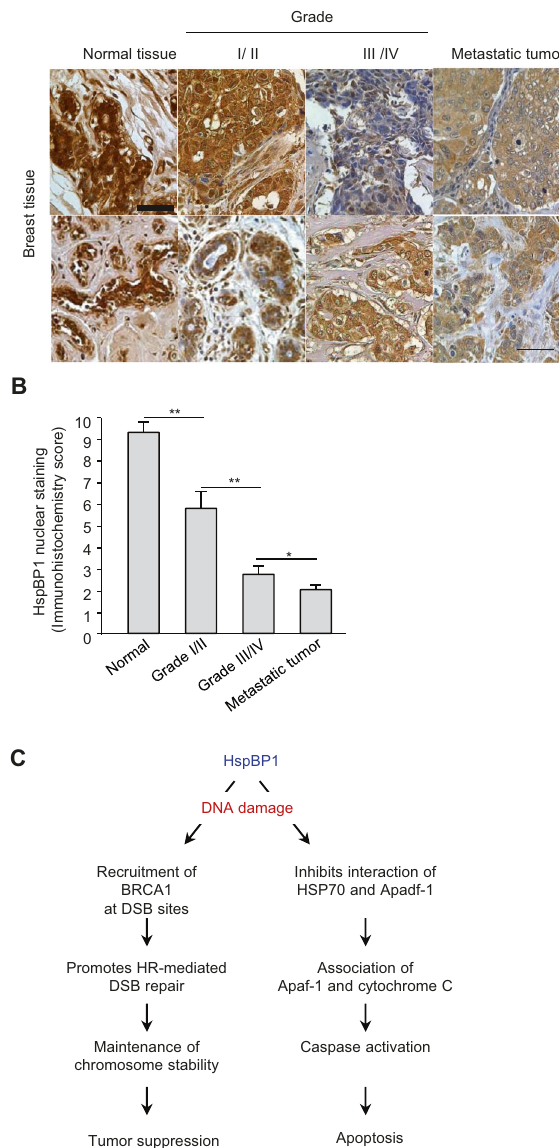
Fig. 8 Expression of HspBP1 in normal and neoplastic breast tissues. A HapBP1 proteins in normal breast tissue, grade I/II, grade III/IV, and metastatic breast carcinoma are visualized using immu- nohistochemistry with an anti-HapBP1 antibody. The brown color indicates positive HspBP1 staining. Nuclei are stained with DAPI (blue). B Nuclear immunoreactivity for HspBP1 was blind-assessed and quanti fi ed by scoring for staining intensity and percent positive cells (see Materials and Methods) in tumor section of grade I/II, III/IV, metastasis, and normal tissue sections from the breast tissue microarray (total 85 samples). Results are shown as the mean ± SD ( n = 3), ** P < 0.01, * P < 0.05. C A schematic representing the role of HspBP1 in tumor suppression and apoptosis. See text for measured the level of activation of caspase-7 and caspase-9, two proteases that are essential in the intrinsic apoptosis pathway. We found that, upon IR exposure, there was signi fi cantly less cleavage of caspase-9 and caspase-7 into active fragments in HspBP1- depleted cells (Fig. 7A, third and fourth panel). Hsp70 is known to interact directly with apoptosis protease- activating factor-1 (Apaf-1), inhibiting the recruitment of procaspase-9 to the apoptosome and thereby suppressing